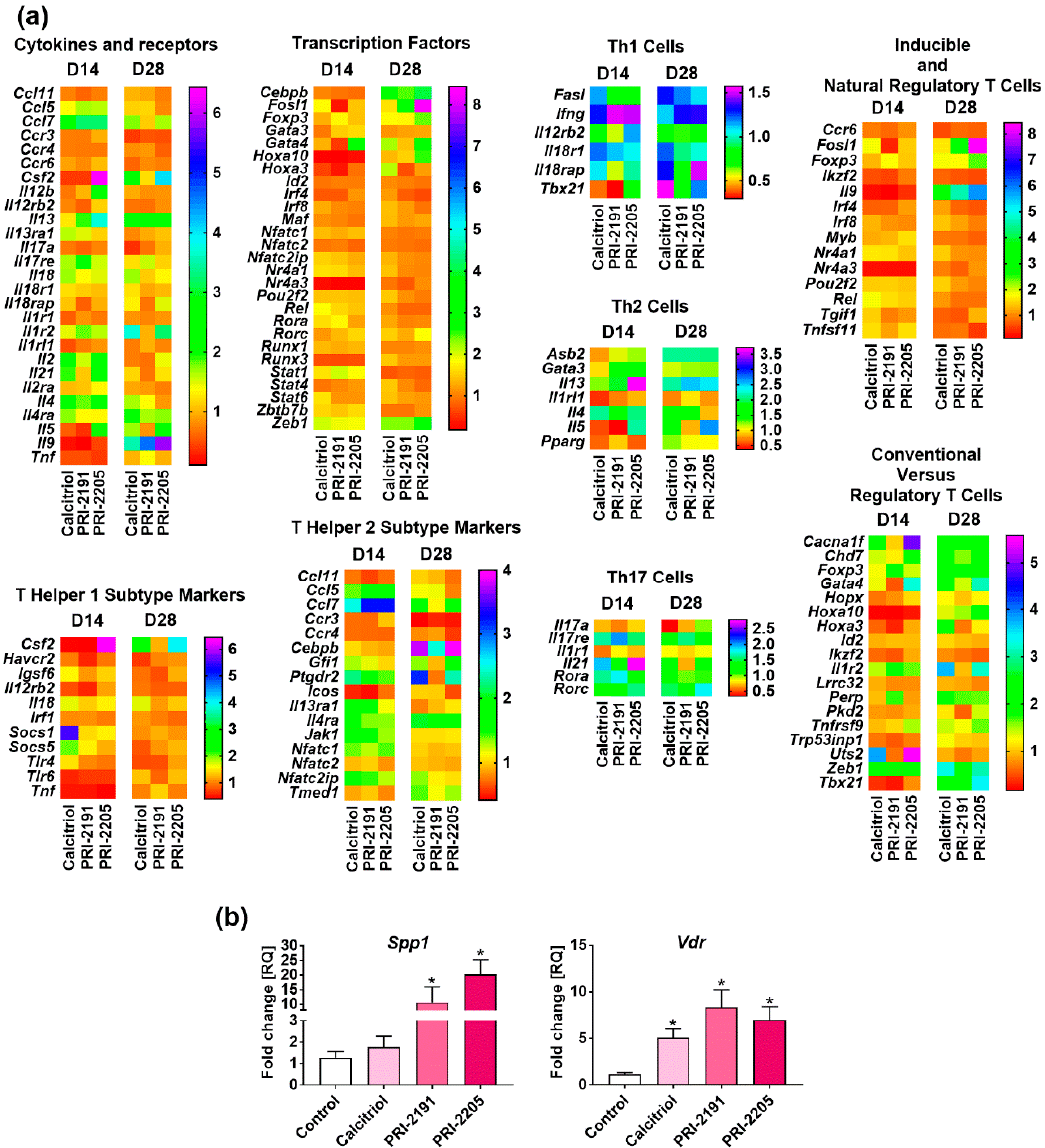
Figure 5. The gene expression in regional lymph nodes from 4T1 tumor bearing mice treated with calcitriol and its analogs. ( a ) Heat maps presenting mean relative quantification (RQ) values from duplicates. The genes were grouped according to the analysis provided by the manufacturer: cytokines and receptors, transcription factors, Th1 and Th2 subtype markers, and epigenetically regulated genes: conventional versus regulatory T cells, inducible and natural regulatory T cells, Th1, Th2, and Th17 cells. Lymph node specimens were collected on the days 21 and 28 (after inoculation with 4T1 cells). Fold-change (RQ) of target cDNA was determined using ∆∆ Ct analysis with reference to actin, beta ( Actb ), and beta-2 microglobulin ( B2m ) and adjusted to the values obtained for the vehicle treated control mice for each treatment group; ( b ) the expression of vitamin D receptor ( Vdr ) and osteopontin ( Spp1 ) mRNA levels (day 28). Data presentation: mean with standard error of mean. Fold-change (RQ) of target genes was determined using ∆∆ Ct method compared with beta-2 microglobulin ( B2m ) and adjusted to the values obtained for the vehicle treated control mice for each treatment group. Number of samples analyzed were 4–6 per group. Statistical analysis: Kruskal–Wallis multiple comparison test. * p < 0.05.